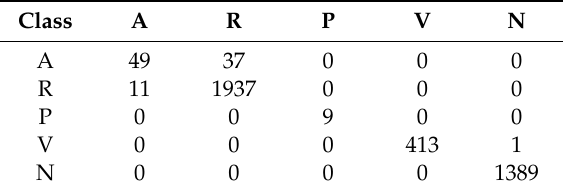
Table 5. Confusion matrix in the training